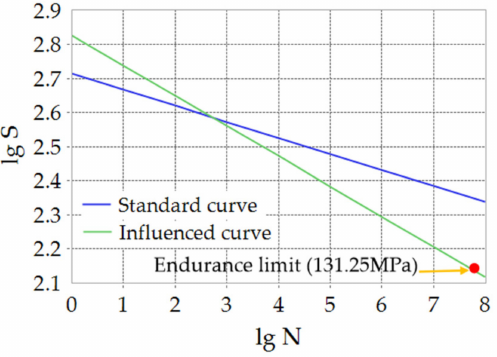
Figure 10. S–N curve of push